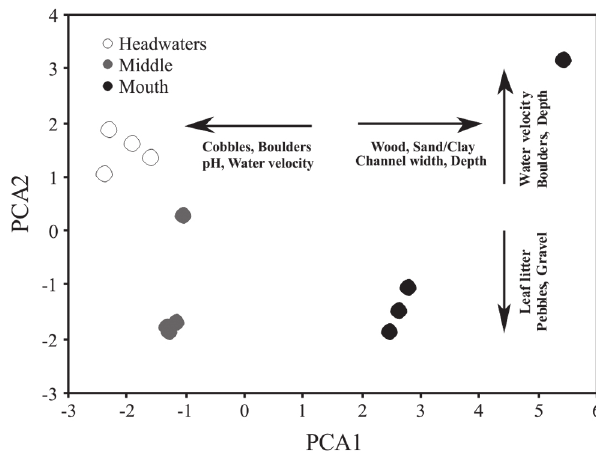
Fig. 2. Ordination of sampling sections along the environmental gradient defined by the first two axes of the principal components analysis (PCA1 and PCA2) applied to the correlation matrix of abiotic variables of the Vermelho River, East Atlantic basin, Antonina, Paraná State, Brazil.